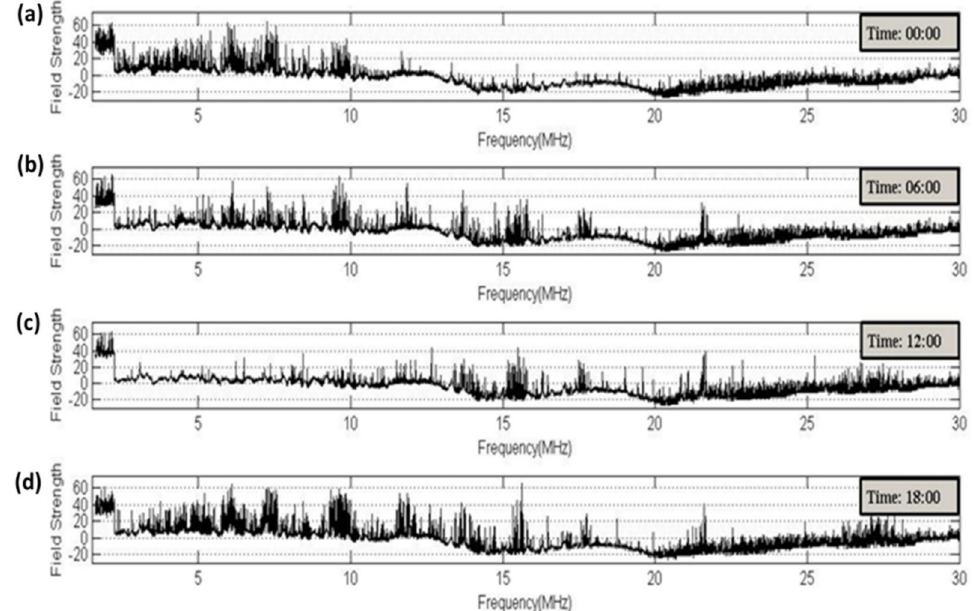
Figure 4. Signal strength measurements across the HF band measured in Cyprus ( a ) at midnight (00:00 LT), ( b ) early morning (06:00 LT), ( c ) noon (12:00 LT), and ( d ) late afternoon (18:00 LT). At noon (12:00 LT), the absorption of HF skywave signals as they pass through the lower ionospheric layer (D-layer) in the lower HF band causes users to shift to the upper segment of the HF band (>20 MHz). Due to maximum ionization, the MUF peaks at noon, and as a result, the higher HF band (i.e., 12–30 MHz) becomes congested, as shown in Figure